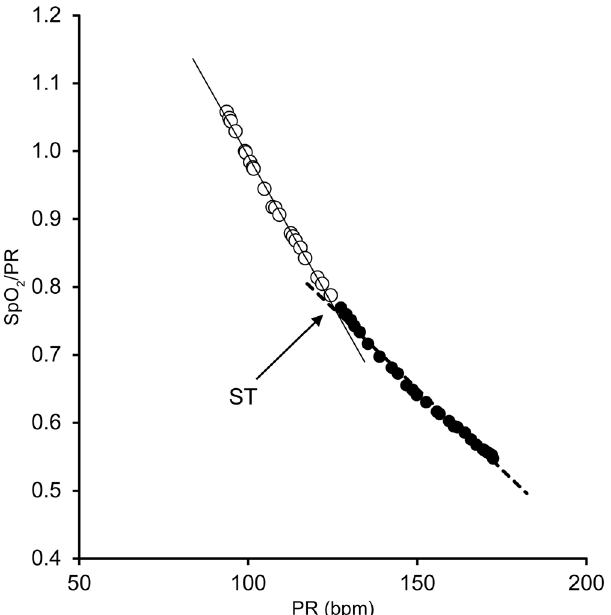
Figure 4. SpO 2 _Slope method for creating ST. ST is the dividing point where the sum of squared residuals of the two regression lines (SpO 2 /PR and PR) is minimized. SpO 2 percutaneous oxygen saturation, ST percutaneous oxygen saturation threshold, PR pulse rate, Bpm beats per